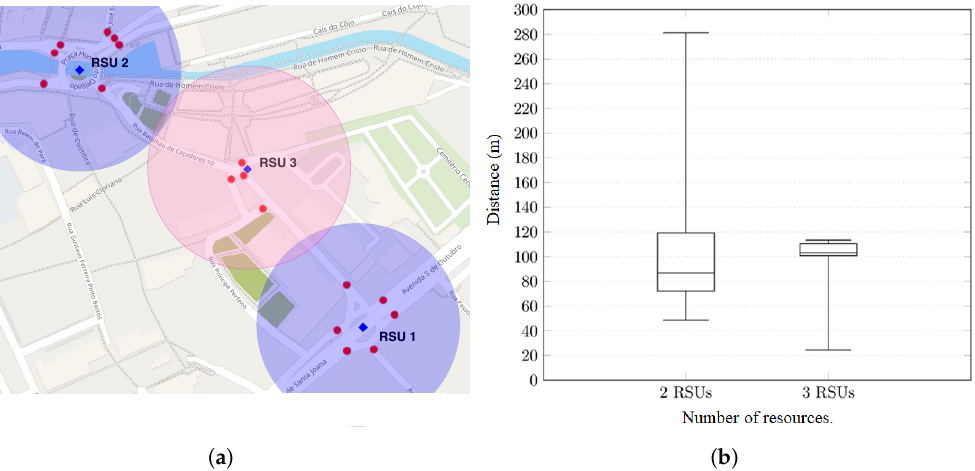
Figure 14. Enhanced scenario with 3 RSUs and their evaluation compared with the previous